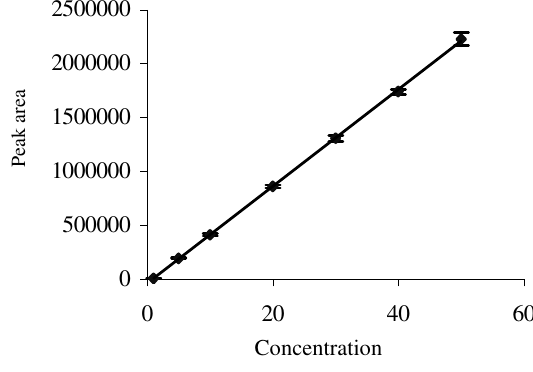
Figure 2. Calibration curve.